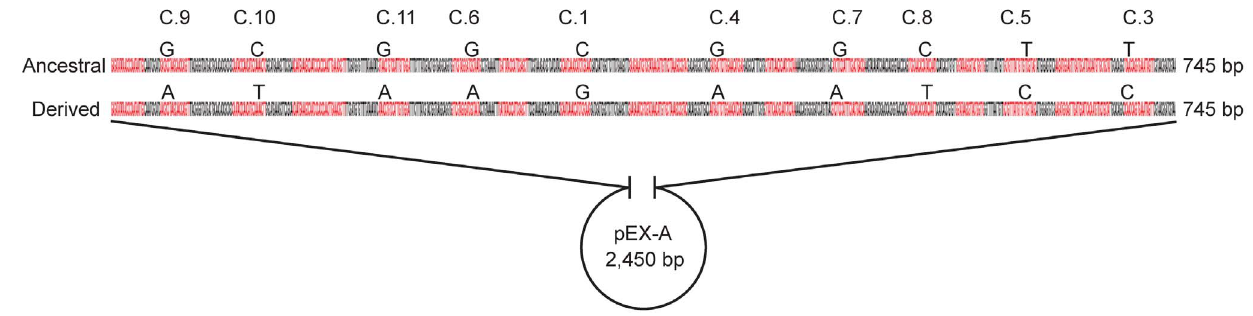
Figure 2. Synthetic vector controls. Two control sequences with ancestral or derived SNP alleles for ten synonymous SNP markers (C.1 to C.11) were synthesized and cloned into the standard vector pEX-A (Fig. S2). Primer binding sites are marked in red, with the SNP states for the markers shown above them.